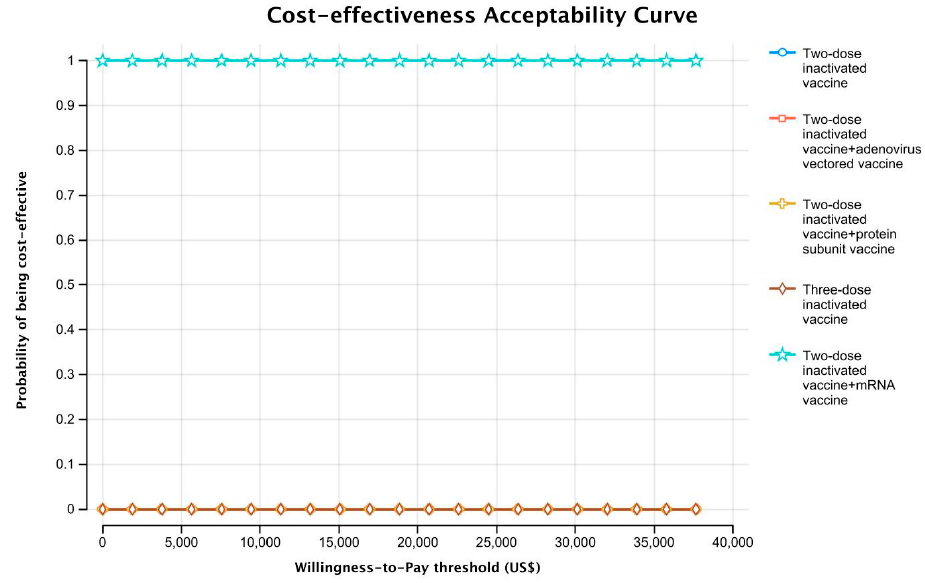
Figure 3. Cost-effectiveness acceptability curve.